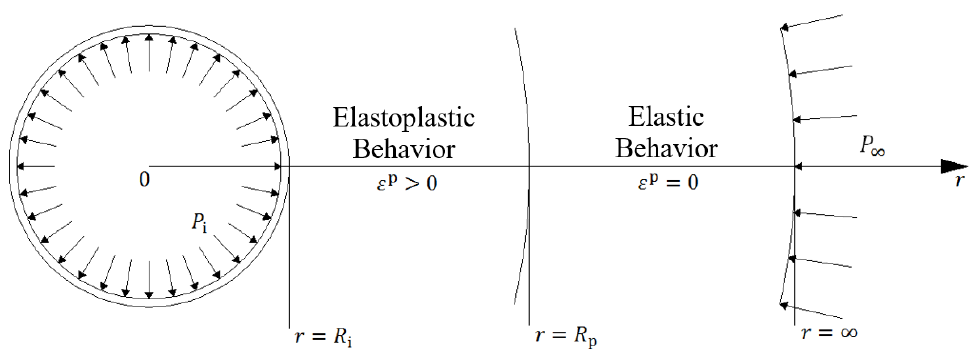
Figure 4. Axisymmetric tunnel within an elastoplastic rock